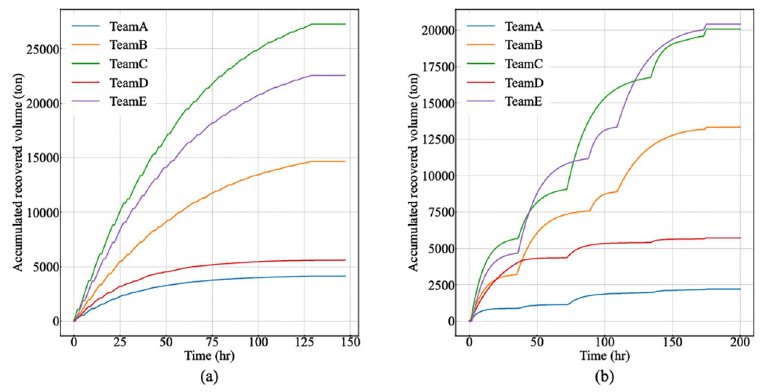
Fig 9. Variations of accumulated recovered volume for each team in MAS-CoPSO and SDS. (a) The results of MAS-CoPSO. (b) The results of SDS.